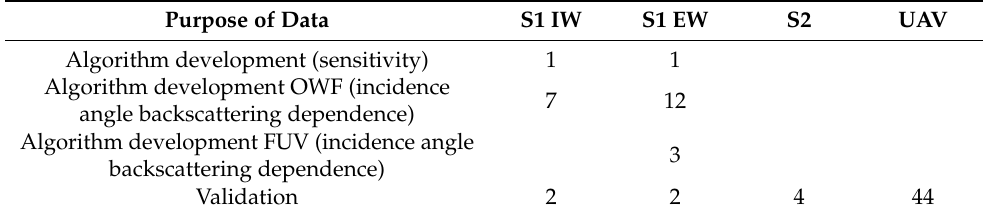
Table 2. Numbers of S1 (IW mode and EW mode), S2, and UAV (unmanned aerial vehicle) im- ages used for algorithm development and validation in open water flood (OWF) and flood under vegetation (FUV) conditions.